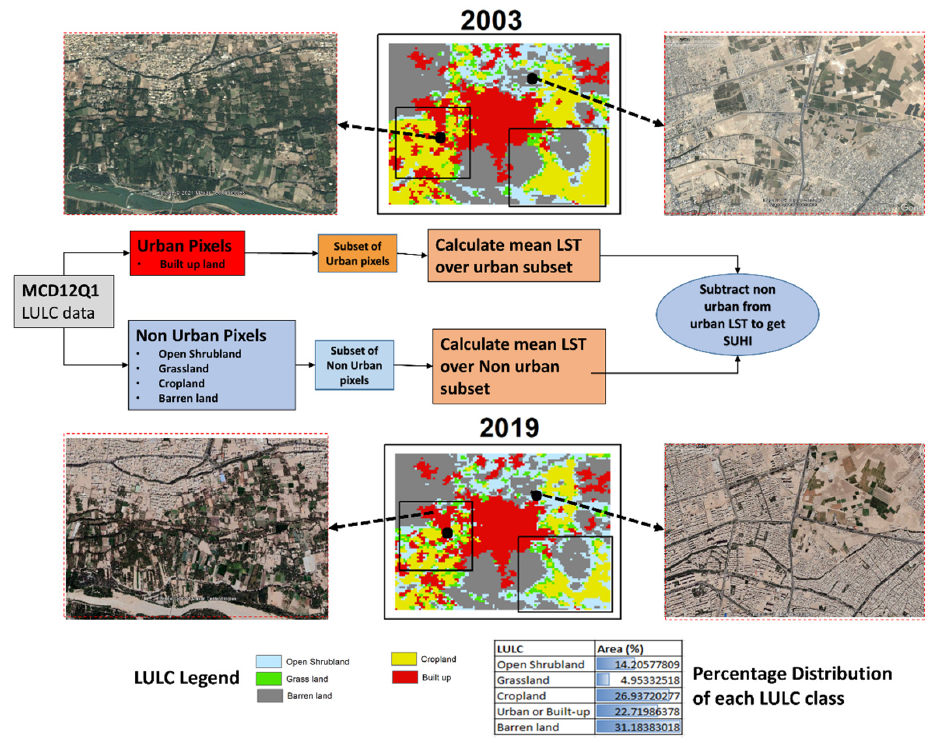
Figure 2. Procedure for estimating surface urban heat island intensity from MODIS.